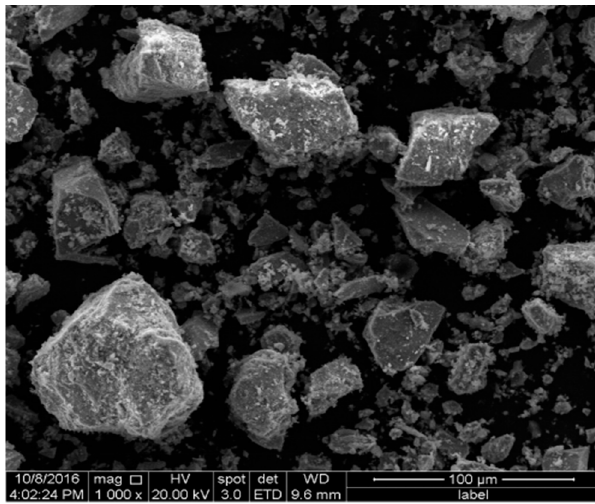
Figure 2. SEM images of chromite concentrate.